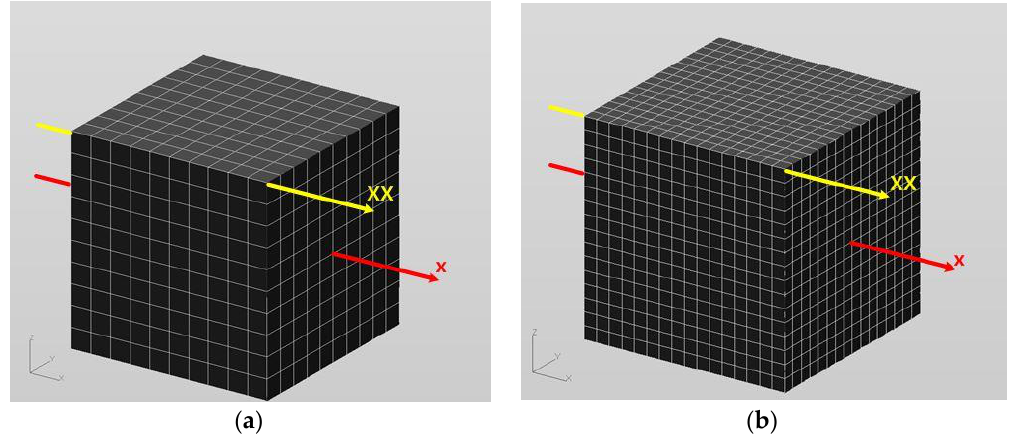
( a ) ( b ) Figure 4. Typical discretized cubic models ( − 4 mm ≤ x, y, z ≤ 4 mm) in the volume integral equation Figure 4. Typical discretized cubic models (−4 mm ≤ x, y, z ≤ 4 mm) in the volume integral equation Table 1. Material properties of the isotropic matrix and the isotropic inhomogeneity. (Unit: GPa)